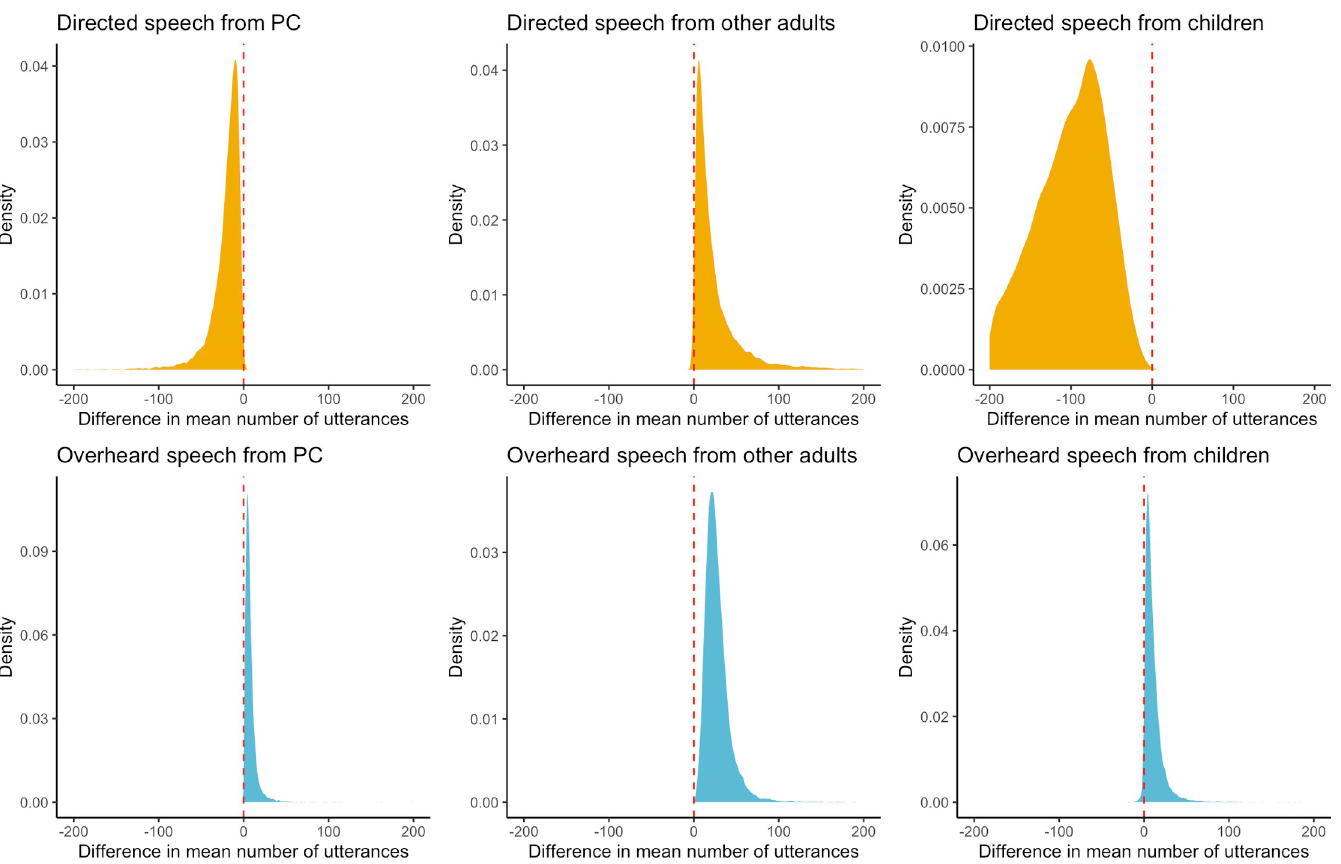
Fig 1. Posterior predictive distribution of the mean difference in number of utterances of each type received by the average child from 2007 to 2013, as obtained from the Zero-Inflated Poisson model including “Cohort” as predictor variable and the number of utterances of each type as response variable. These were obtained by averaging from 12000 samples from the posterior distribution (setting the standard deviations for the varying intercepts to 0). From top-left to bottom-right: Directed input from primary caregiver, directed input from adults, directed input from children, overheard input from primary caregiver, overheard input from adults, overheard input from